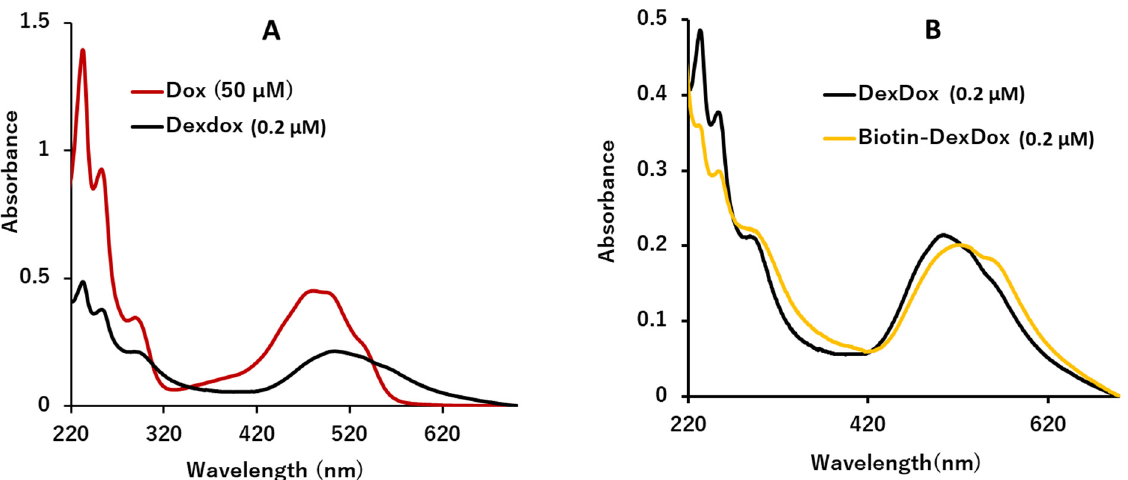
Figure 2. ( A ) UV spectra of 50 µ M of doxorubicin and 0.2 µ M DexDox and ( B ) UV spectra of 0.2 µ M of DexDox and Biotin-DexDox.